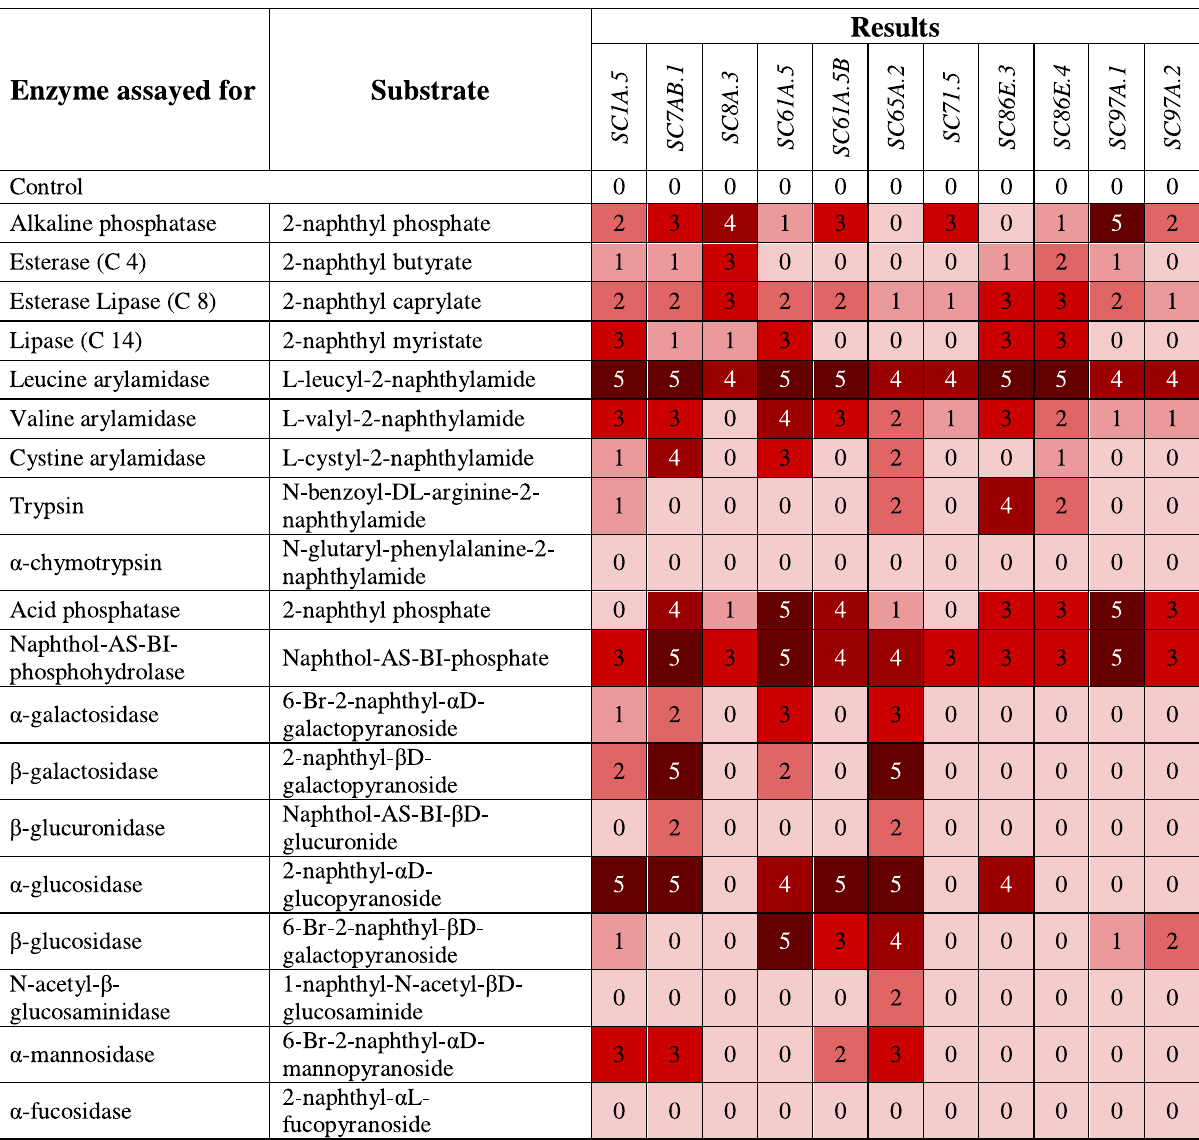
Table 2. API ZYM enzymatic activity of cave ice isolated strains. The color intensity decreased with the level of enzymatic activity from 5 (high) to 0 (no activity). The numbers correspond to the amount of hydrolyzed substrate (nmol), as indicated in “Methods”